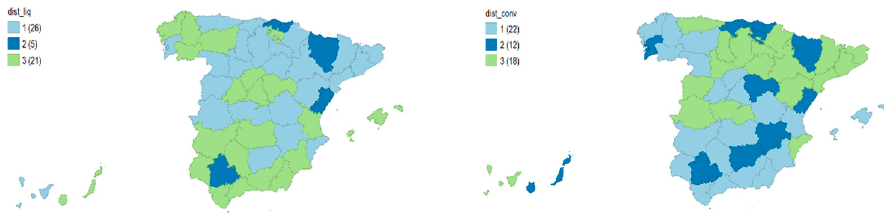
Figure 1. Spatial distribution of specialization indexes of convenio and liquidation by provinces. In contrast, southern provinces show higher liquidation rates (on the left figure, green colors). This first mapping shows a north/south trend, with mortality being lower in the regions in the north than in the south of Spain. This evidence requires a deeper study of the reasons behind such regional disparities in bankruptcy